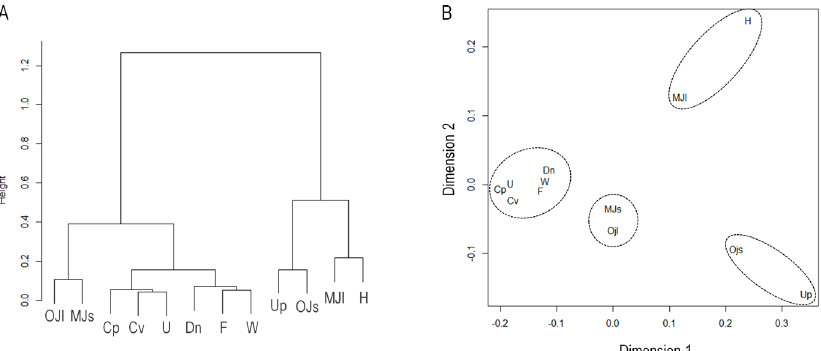
Fig 6. Multidimensional scaling analysis of syllable types. Hierarchical clustering (A) and an MDS plot (B) of context-specific changes in the proportion of each syllable type; Upward (Up), Downward (Dn), Flat (F), Chevron (Cv), U shape (U), Wave (W), Complex (Cp), One jump short (OJs), One jump long (OJl), Multiple jumps short (MJs), Multiple jumps long (MJl), and Harmonics (H).